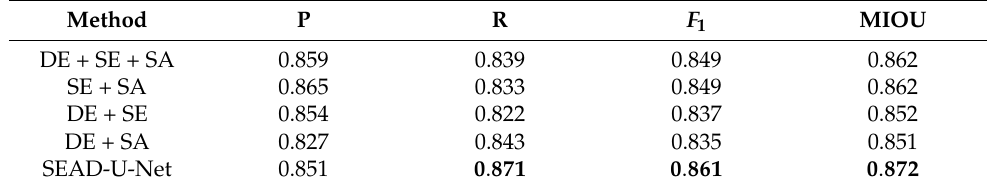
Table 5. Experimental results of different module combinations on DeepCrack.